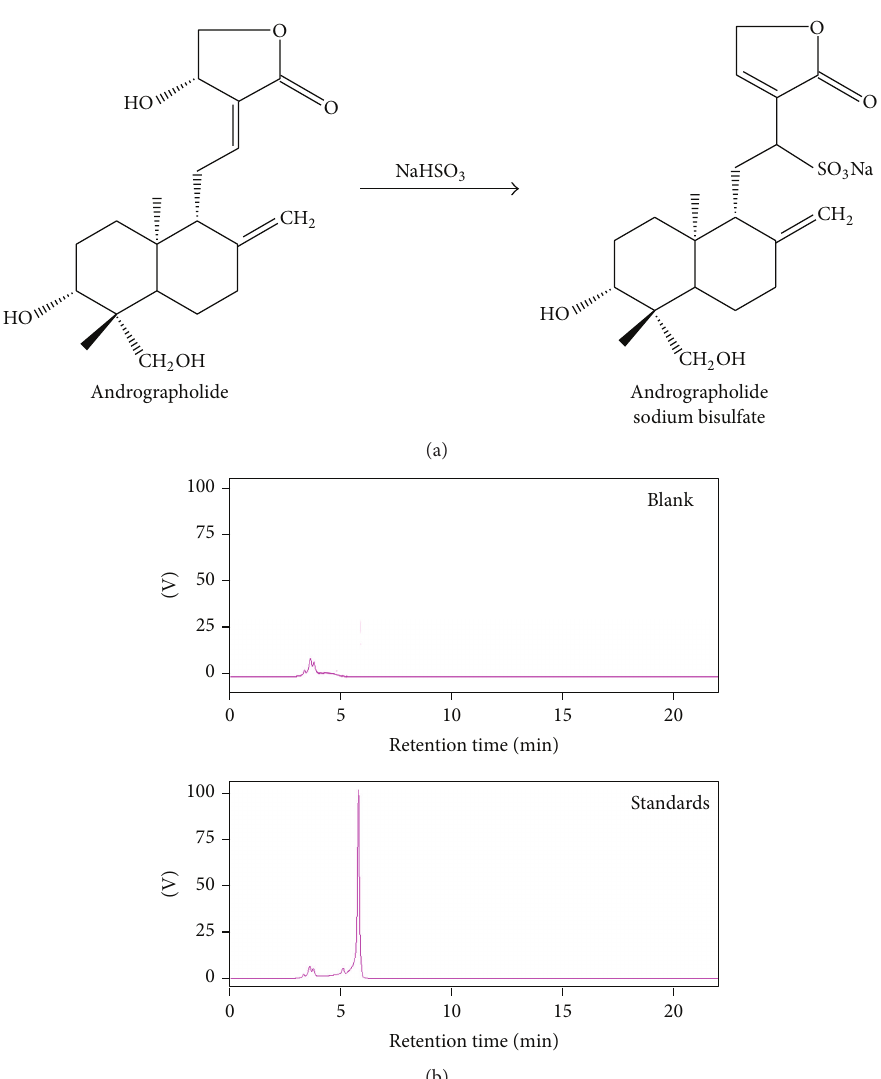
Figure1:Andrographolidesodiumbisulfate.(a)Andrographolidesodiumbisulfate(ASB)ismadefromandrographolidethroughsulfonating reaction. (b) HPLC chromatogram of